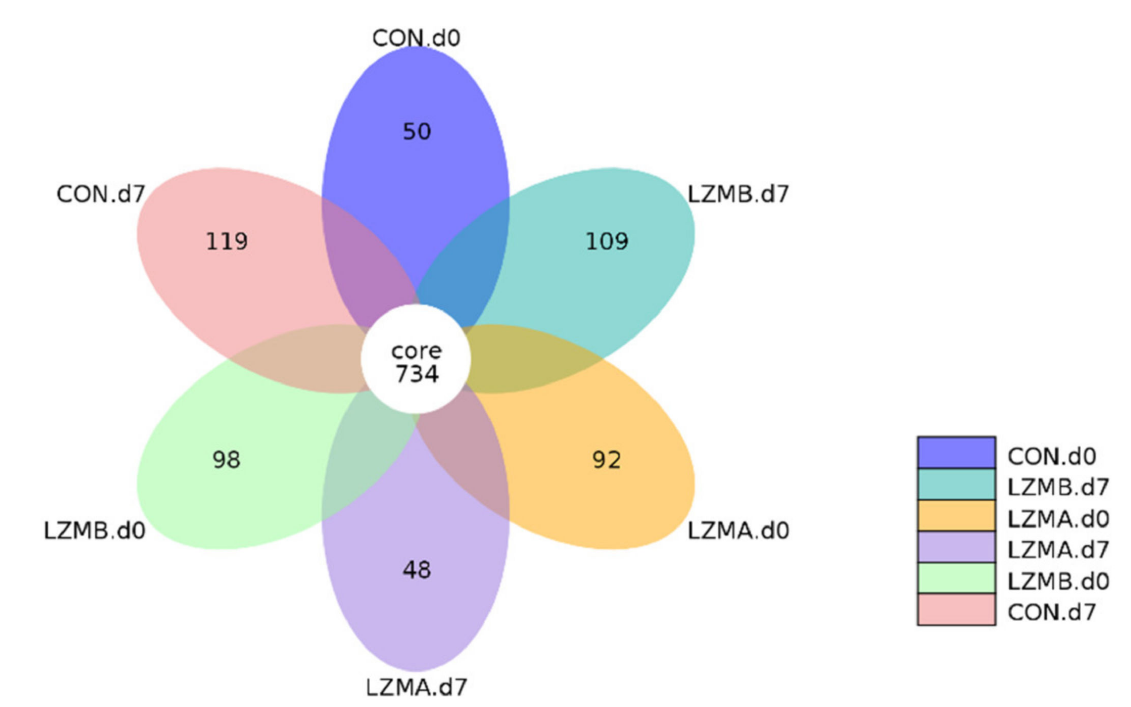
Figure 1. Venn diagrams were generated to compare OTUs between the different treatments of sow vaginal samples on the day of farrowing (d 0) and day 7 of lactation (d7). Venn diagram was generated to describe the common and unique OTUs among treatments at different day of lactation in sow vagina. CON. d0 = control diet at the day of farrowing, CON. d7 = control diet at day 7 of lactation, LZMA d0 = control diet + lysozyme 150 mg/kg at the day of farrowing, LZMA d7 = control diet + lysozyme 150 mg/kg at day 7 of lactation, LZMB d0 = control diet + lysozyme 300 mg/kg at the day of farrowing, LZMB d7 = control diet + lysozyme 300 mg/kg at day 7 of